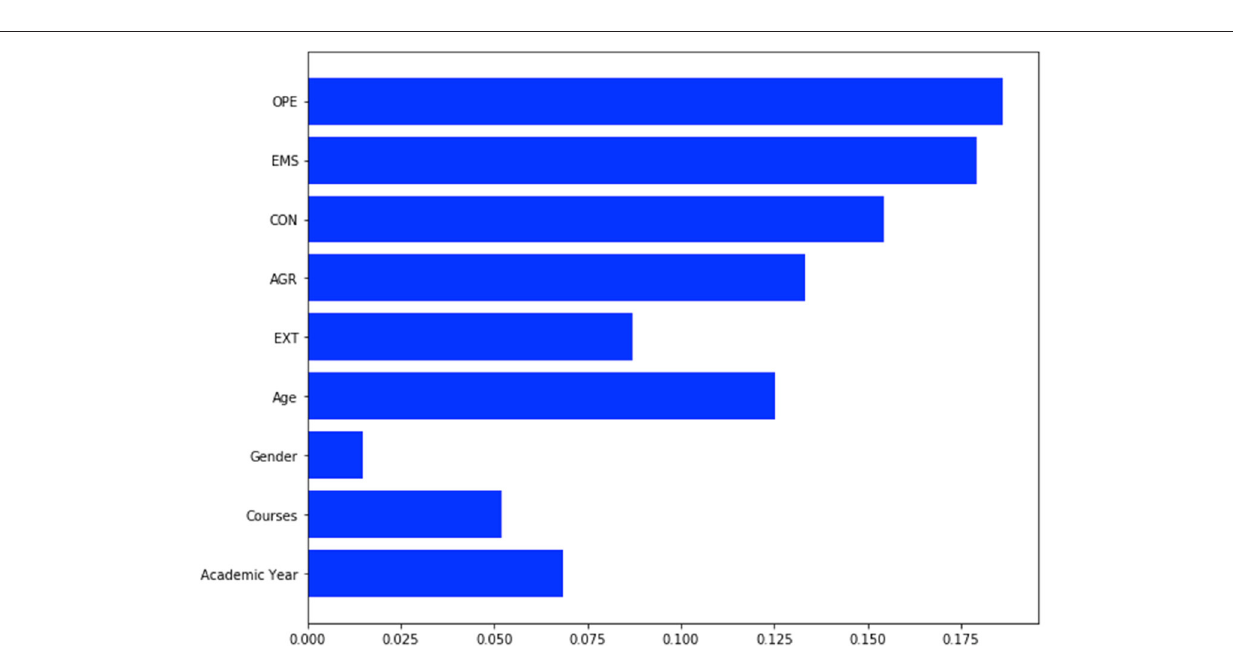
Finally, a previous experience with psychiatric patients (i.e., a training experience in a psychiatric unit) was associated to lower scores on Danger, Fear, Segregation, Help and